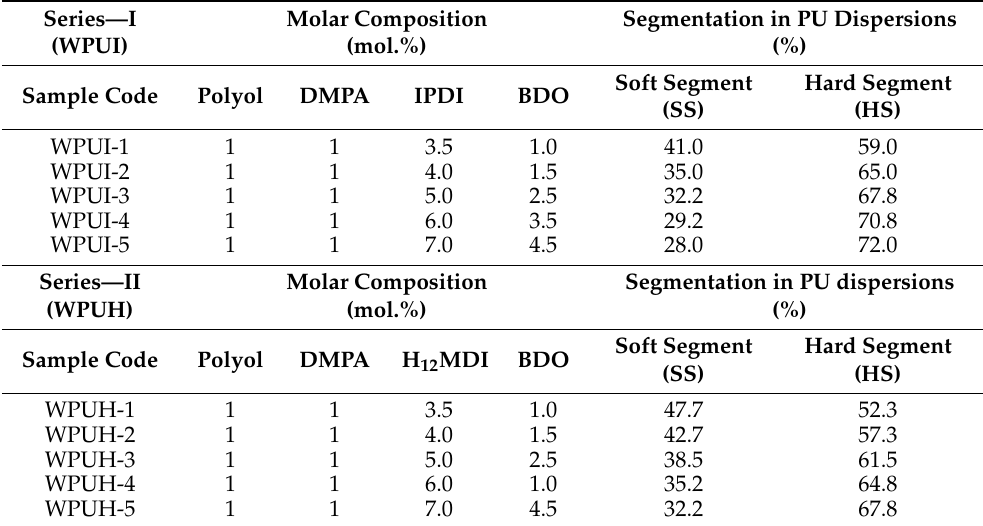
Table 1. Sample code designation, stoichiometry, and physical properties of